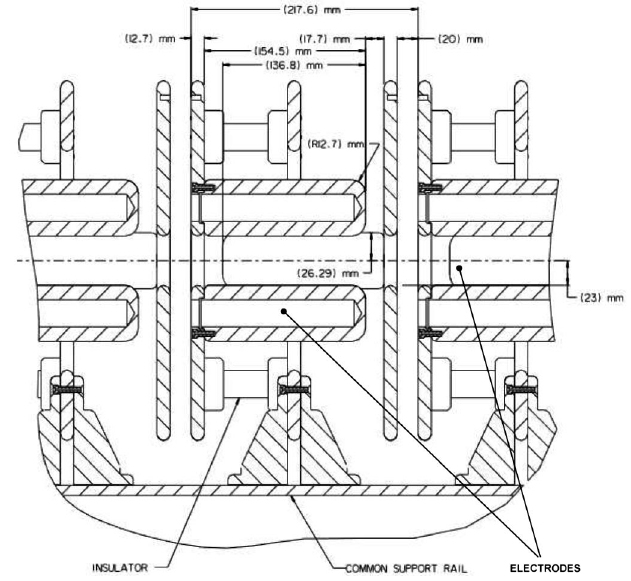
FIG. 6. Mechanical drawing (side view) of a quadrupole in- stalled on the beam